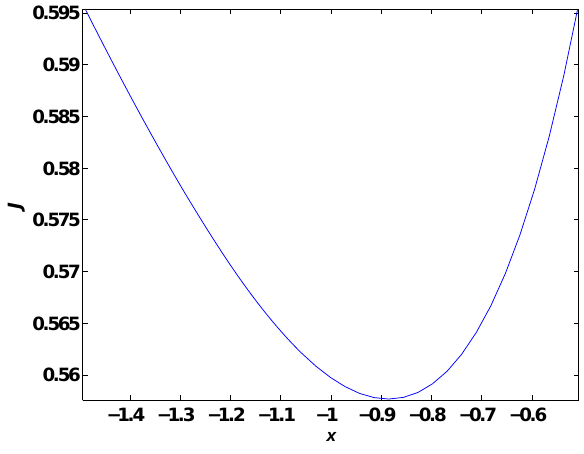
Fig. 1. Optimization